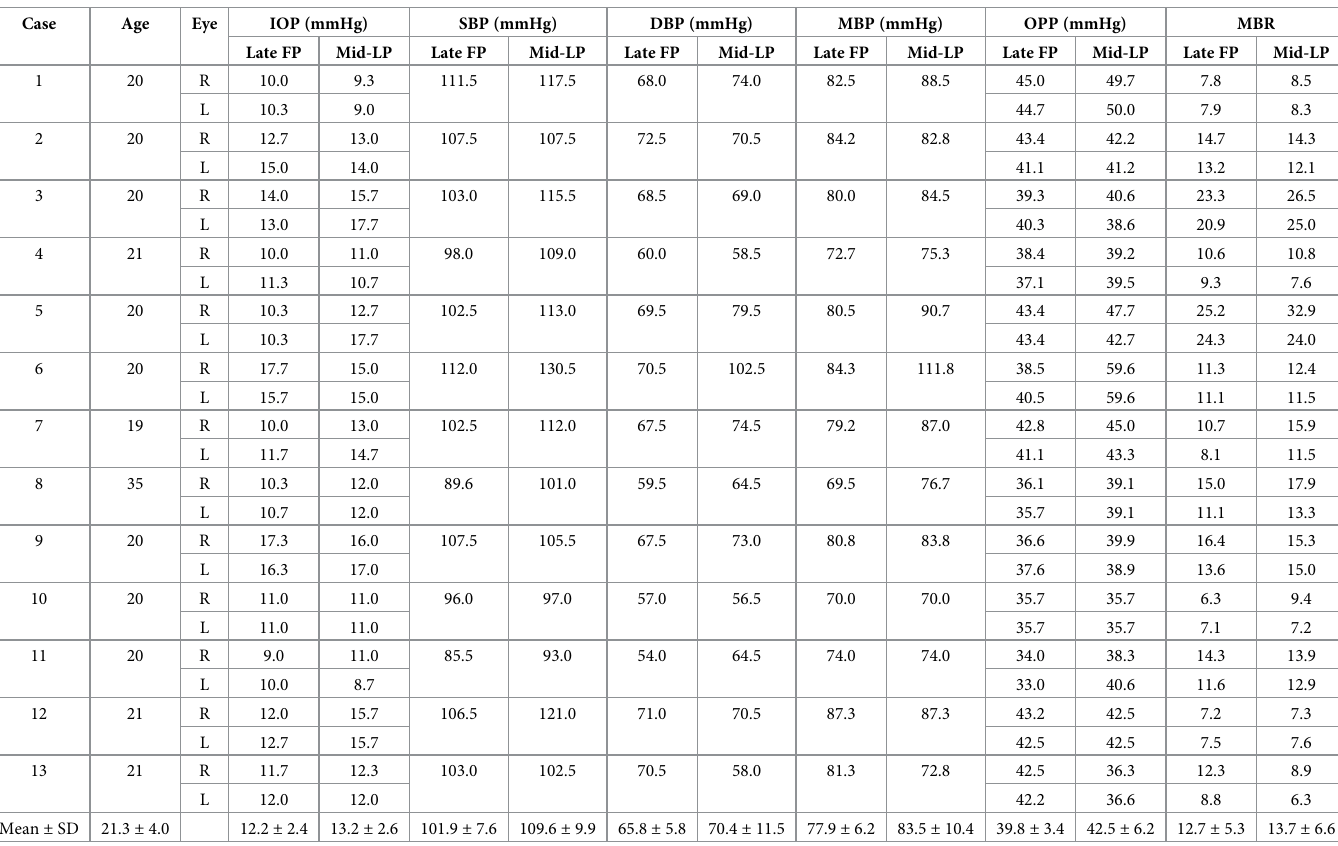
Table 1. Characteristics of and changes in intraocular pressure and systemic factors in female